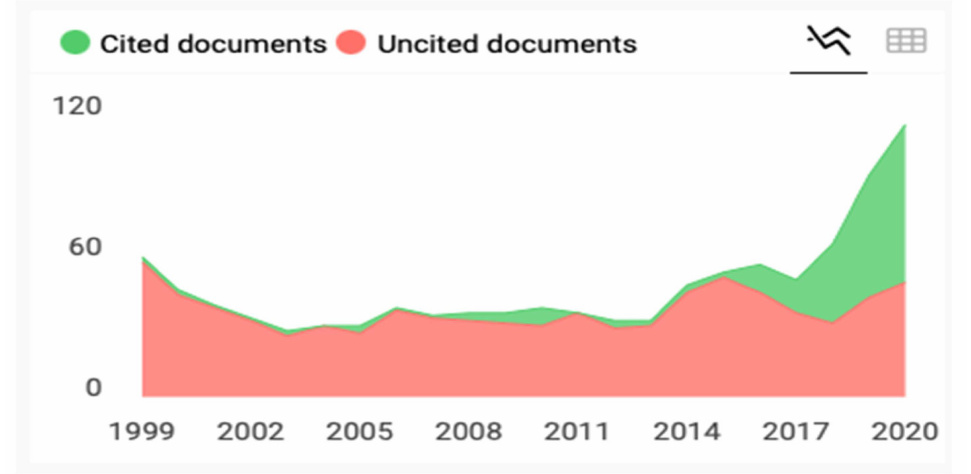
Figure 8. The analysed journal cited vs. uncited documents ratio. Note the increasing trend reflected in fractions 48/39 = 1.23 in 2019, and 62/45 = 1.38 in